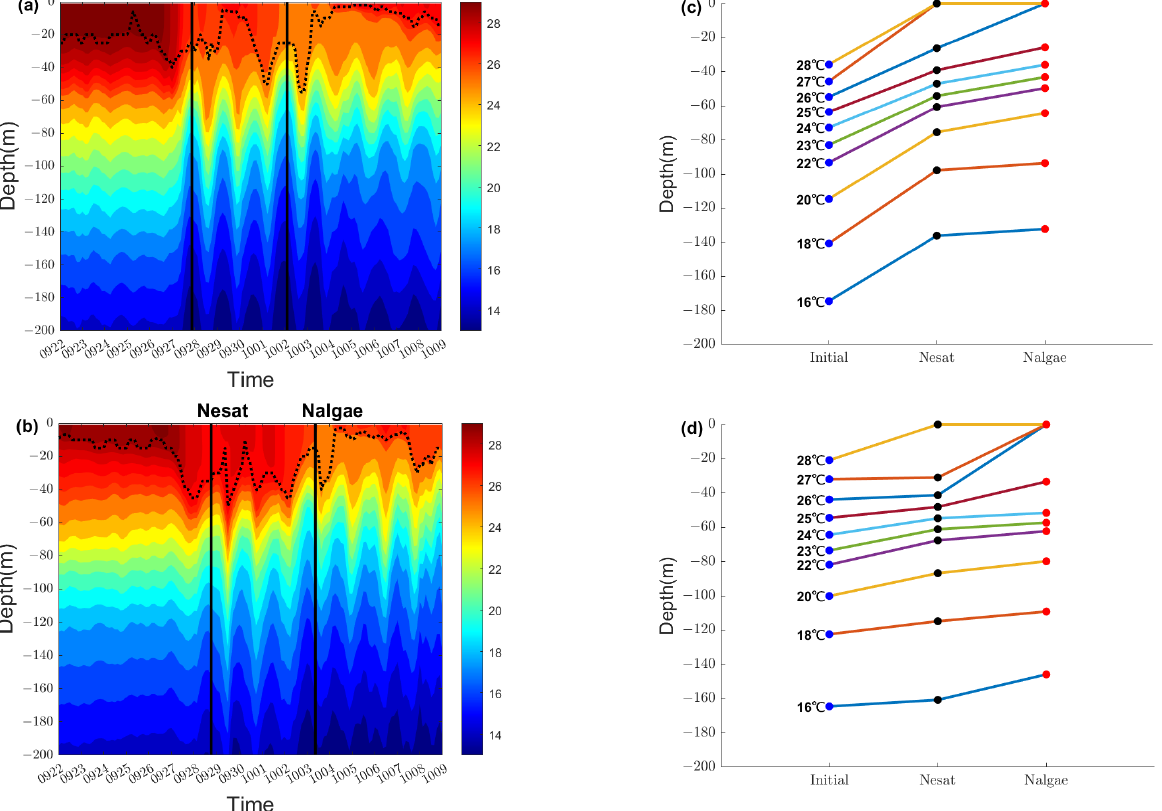
Figure 6. ( a , b ) The change in vertical temperature in sea areas S1 \ S2 (the black dotted line indicates the depth of the mixed layer); ( c , d ) the depth of the isotherm in the S1 \ S2 area where two typhoons pass.